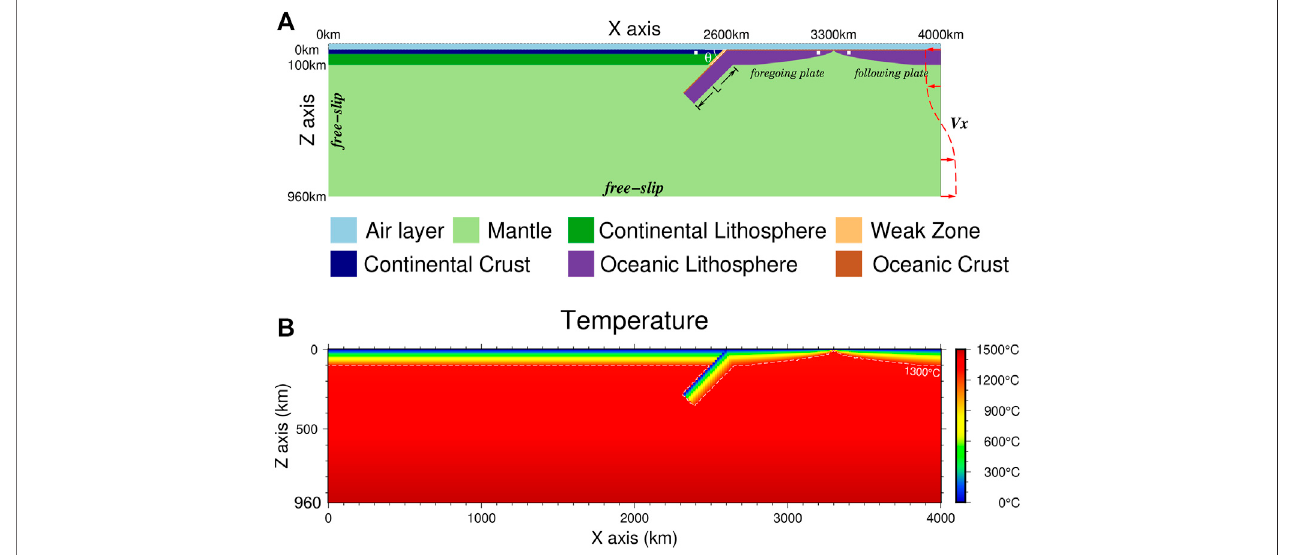
FIGURE 1 | Model initial setting and boundary conditions. (A) The 2-D model is 4,000 × 1,000 km with an air layer 40 km thick at the top. At 3,300 km in the horizontaldirection, weset upanMOR structure, andthe twosidesoftheMOR aretheforegoingoceanicplateandthe followingoceanicplate.Thethree whitesquares represent the sampling points placed in the model. Different colors in the model represent different lithologies, as shown at the bottom. θ is the initial dip angle of the foregoing plate. The initial slab length (L) and the imposed velocity ( V x ) at the right boundary are the main control parameters in our model. (B) Initial temperature fi eld. The white dashed line is the 1,300 ° C isotherm, which represents the bottom boundary of the lithosphere.